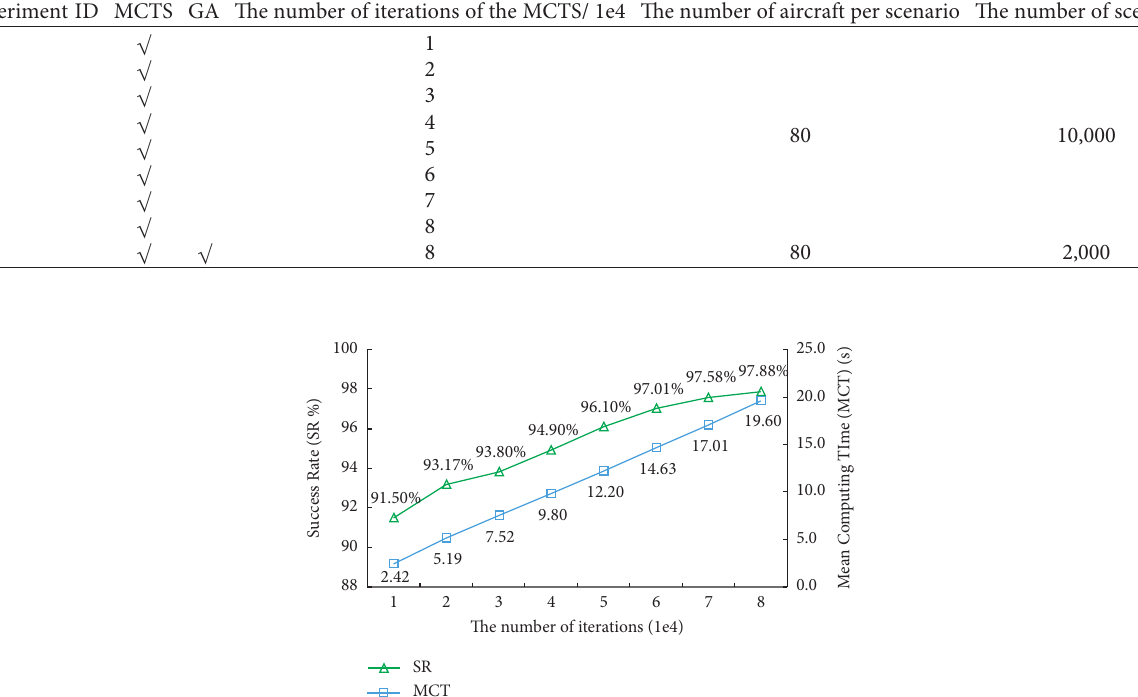
Figure 11: The change of the success rate and the mean computing time with the increase of the number of iterations.